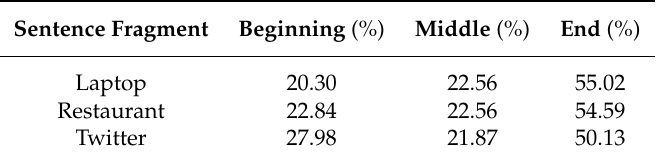
Table 4. Aspect word location in sentence. Sentences are divided into three fragments, being the beginning, middle and end to determine the fragment each aspect word is found in.